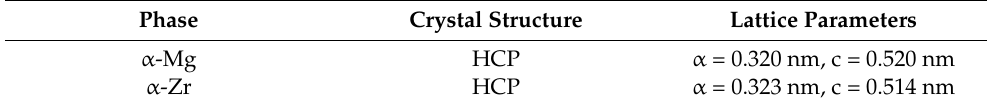
Table 2. The crystal structure and lattice parameters of Mg and Zr [41]. Phase